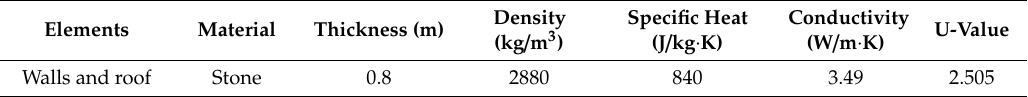
Figure 4. Different views of the building: ( a ) right view (east-facing façade), ( b ) left view (west-facing façade), ( c ) front view (south-facing façade). Table 2. Construction materials and their specifications.